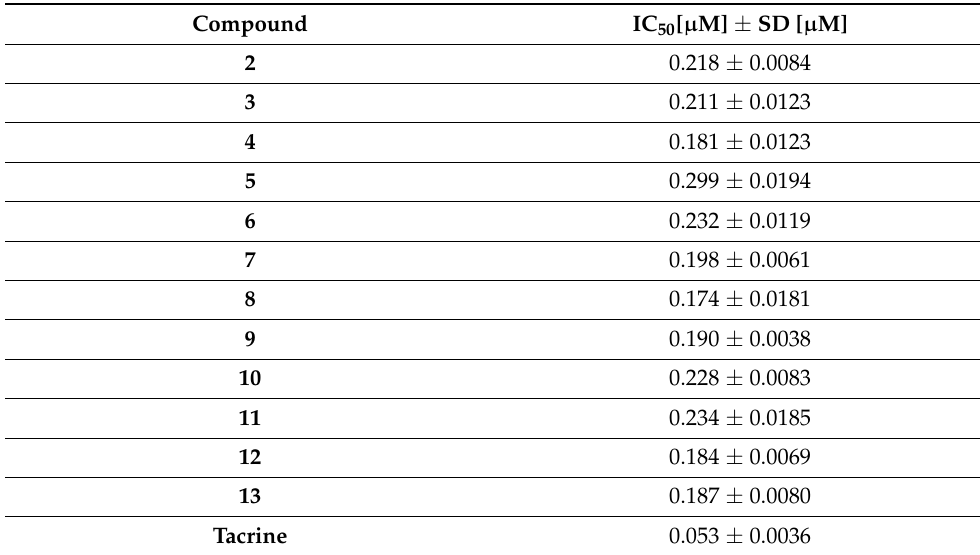
Table 3. Anti-AChE activity of coumarin-thiadiazole hybrids and their corresponding Cu(II) and Zn(II) complexes 2 – 13